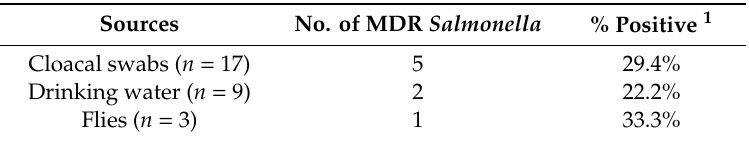
Figure 3. Frequency of resistance of Salmonella isolates from village chickens of the South-central Peninsular Malaysia according to the chicken production systems (Te, Tetracycline; S, Streptomycin; W, Trimethoprim; S3, Sulfonamides; Amp, Ampicillin; Na, Nalidixic acid; Cn, Gentamicin; Ct, Chloramphenicol; F, Nitrofurantoin; Ctx, Cefotaxime; Amc, Amoxicillin-clavulanate). Table 3. Distribution of multidrug resistant (MDR) Salmonella isolates recovered from native chickens of the South-central Peninsular Malaysia.